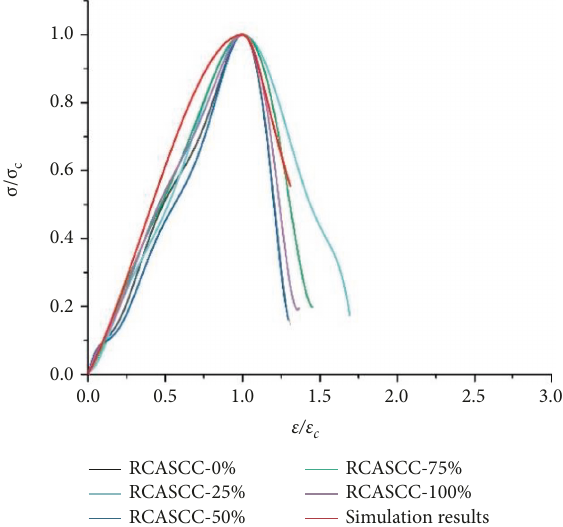
Figure 14: Comparison of fitted stress-strain